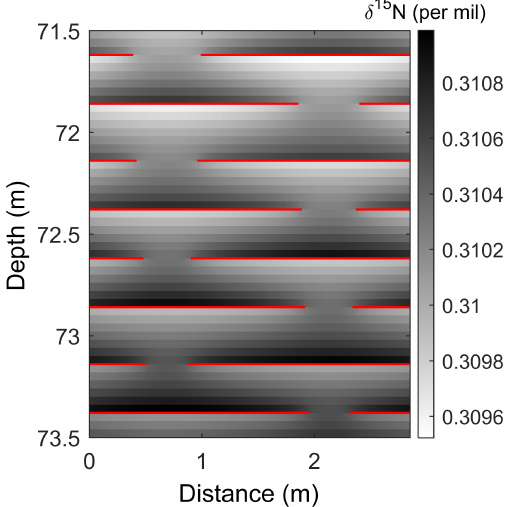
Figure 8. Simulated δ 15 N in a section of the lock-in zone at WAIS Divide from the 2-D model not including barometric pumping. Im- permeable horizontal layers are shown in red. The size of the open- ings in the layers shrink with increasing